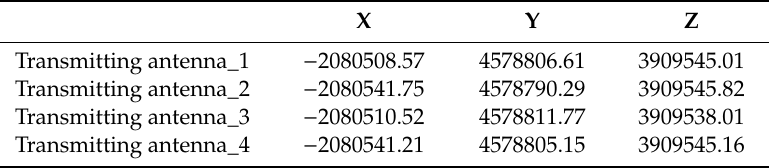
Table 1. Coordinates of the four transmitting